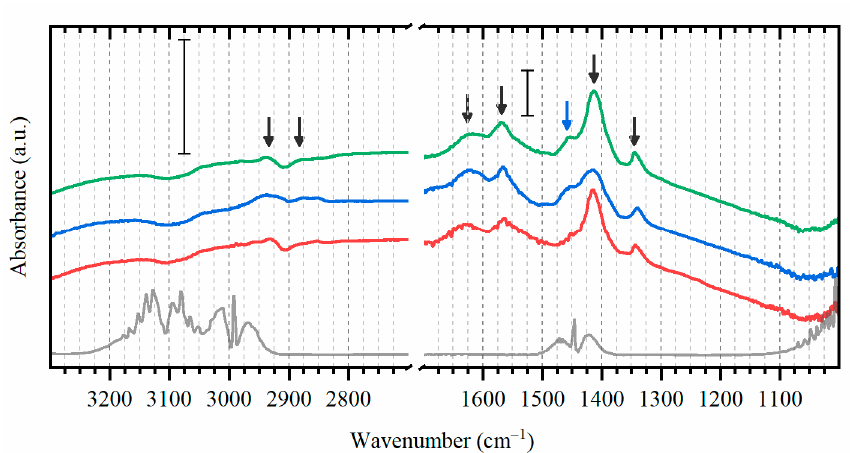
Figure 4. Background subtracted experimental DRIFTS data (after normalization and subtraction of spectrum of the activated state) for Pd catalyst after exposure to C 2 H 4 . The subsequent spectra were collected in argon (red), in hydrogen (blue) and again in argon (green). Black line corresponds to the reference spectrum of gas-phase ethylene [71]. For clarity, the spectra are shifted in vertical direction. The scale bars demonstrate that the left part is enlarged with respect to the right one.